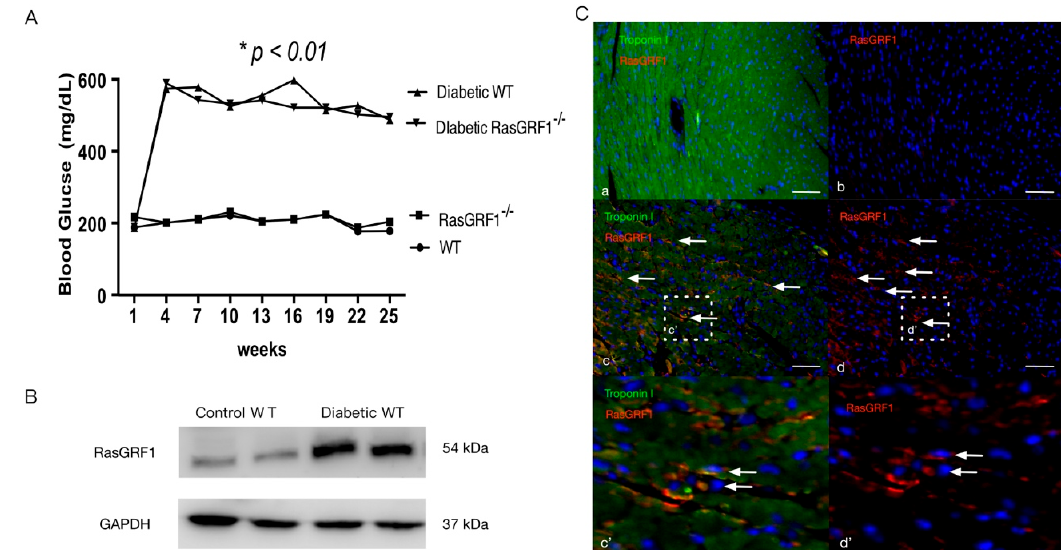
Figure 1. Dynamic expression of Ras protein-specific guanine nucleotide releasing factor 1 (RaGRF1) in the cardiac tissue of non-diabetic and diabetic mice. ( A ) Peripheral blood glucose concentration was measured once every two weeks. Fasting blood sugar level was measured biweekly in wild-type (WT) B6 mice, RasGRF1 − / − mice, diabetic WT B6 mice, and diabetic RasGRF1 − / − mice (each group, n = 12). Values represent mean ± SEM ( n = 12). The diabetic mice exhibited higher fasting blood sugar levels than the sham control, but there was no difference between diabetic WT B6 mice and diabetic RasGRF1 deficiency (RasGRF1 − / − ) mice. * p < 0.01, vs. non-diabetic groups; ( B ) Mice were divided into sham control ( n = 2) or 24-week period diabetic wild-type (WT) mice ( n = 2) induced by streptozotocin (STZ) injection. Immunoblotting for RasGRF1 was performed, and it was observed that the expression of RasGRF1 was significantly upregulated in diabetic wild-type mice compared to control WT mice. ( C ) Dual immunofluorescence staining was performed with RasGRF1 (red) and troponin I (green) in sham control and diabetic WT mice. An increased expression of RasGRF1 (white arrow) in diabetic mice (a–d) was observed and the positive RasGRF1 cells were not co-localized with troponin I. (c’ and d’ are enlarged images of c and d) WT: Wild-type.